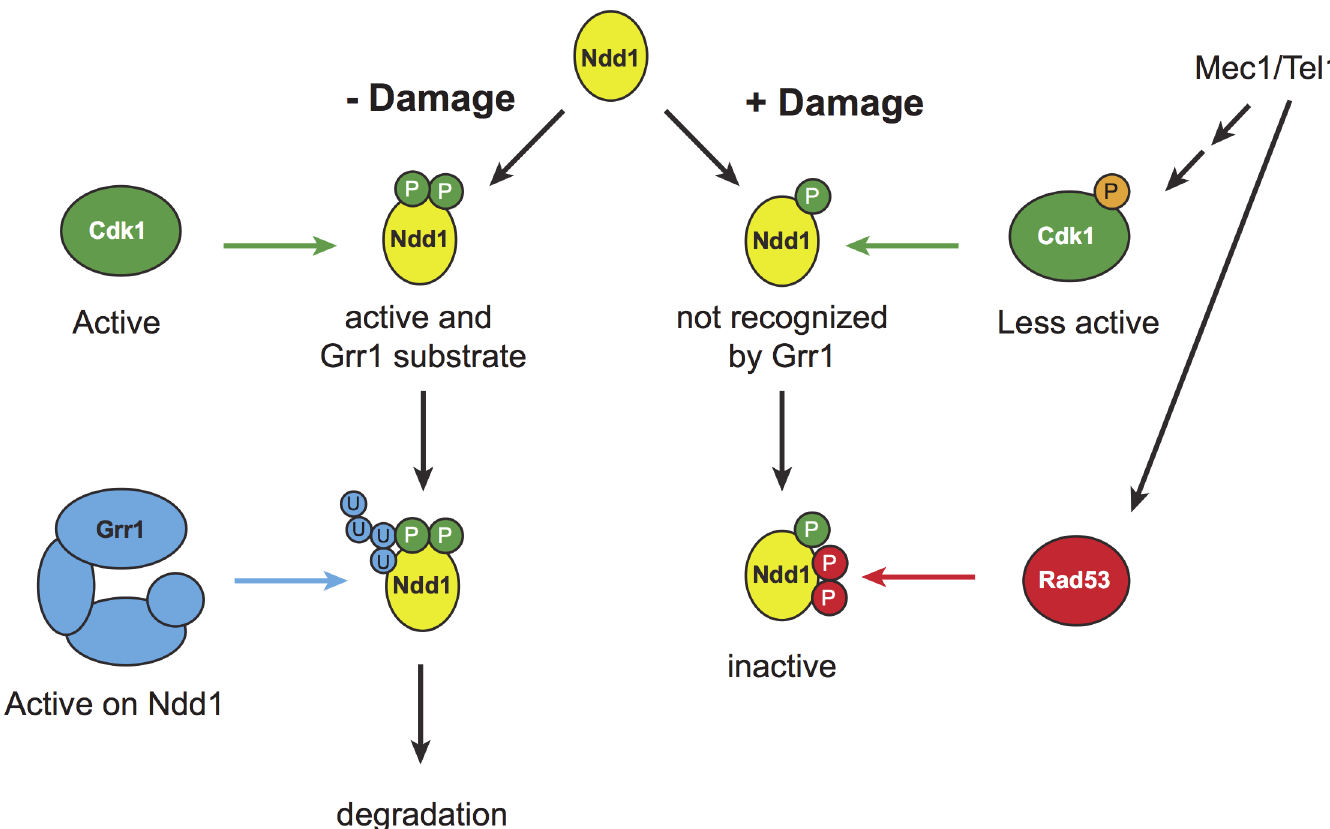
Fig 5. Model for mitotic turnover of Ndd1. In the absence of DNA damage, Ndd1 is phosphorylated by Cdk1, which promotes Ndd1 transcriptional activity but also enables SCF Grr1 to recognize Ndd1 as a substrate. Ndd1 is therefore ubiquitinated and subsequently degraded. In response to DNA damage, Swe1 levels are increased, and Cdk1 is inhibited by phosphorylation which lowers its activity several fold. Ndd1 is no longer recognized by Grr1 and is therefore stabilized. Mec1 and Tel1 are important for maintaining high levels of phospho-Cdk1, and therefore help to stabilize Ndd1, either by promoting Swe1 activity or by inhibiting the phosphatase Mih1 (homolog of Cdc25). While Ndd1 is stabilized, its activity is independently inhibited by Rad53-dependent phosphorylation, leading to the accumulation of inhibited Ndd1. We speculate that maintaining this inhibited pool of Ndd1 may allow the cell to rapidly re-enter the cell cycle once the damage is repaired and the checkpoint is turned